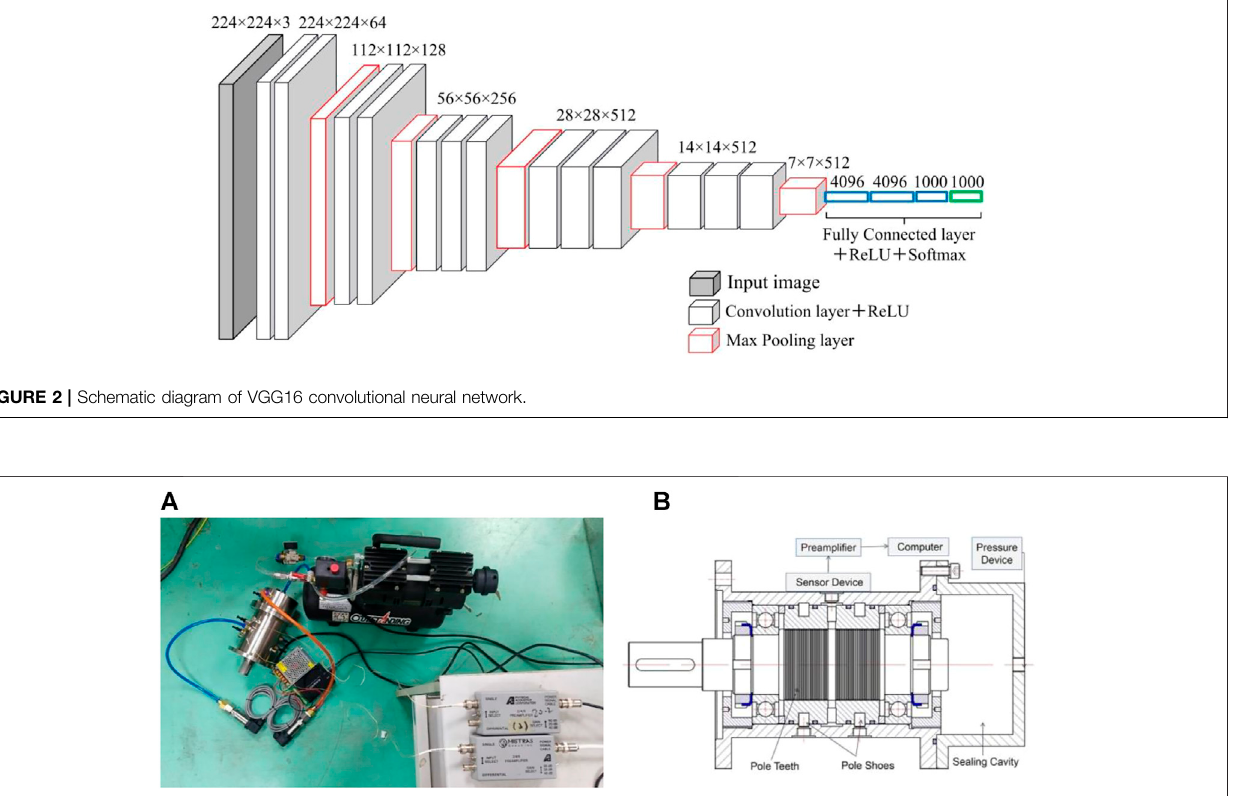
Frontiers in Materials |